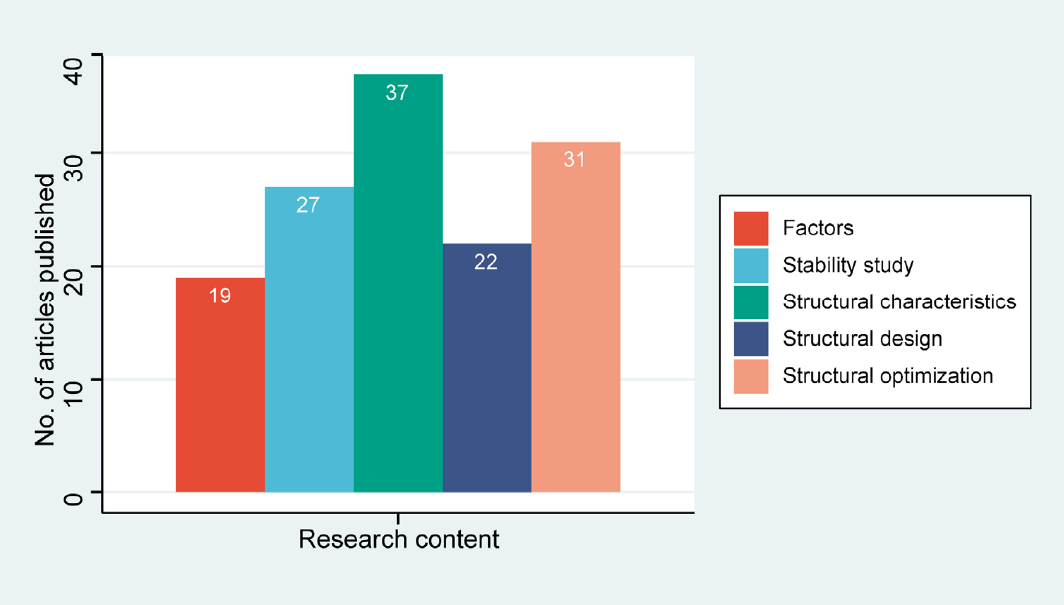
Figure 3. Research content division.